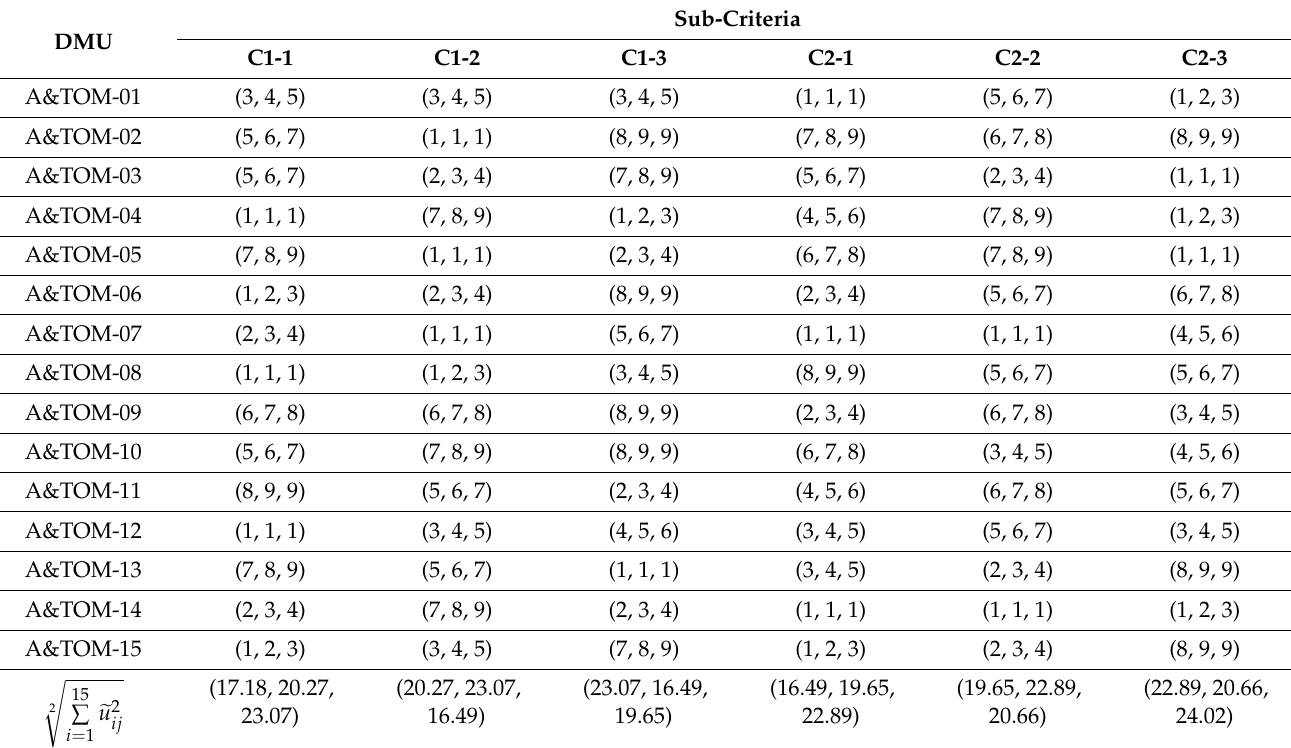
Table A1. Fuzzy decision